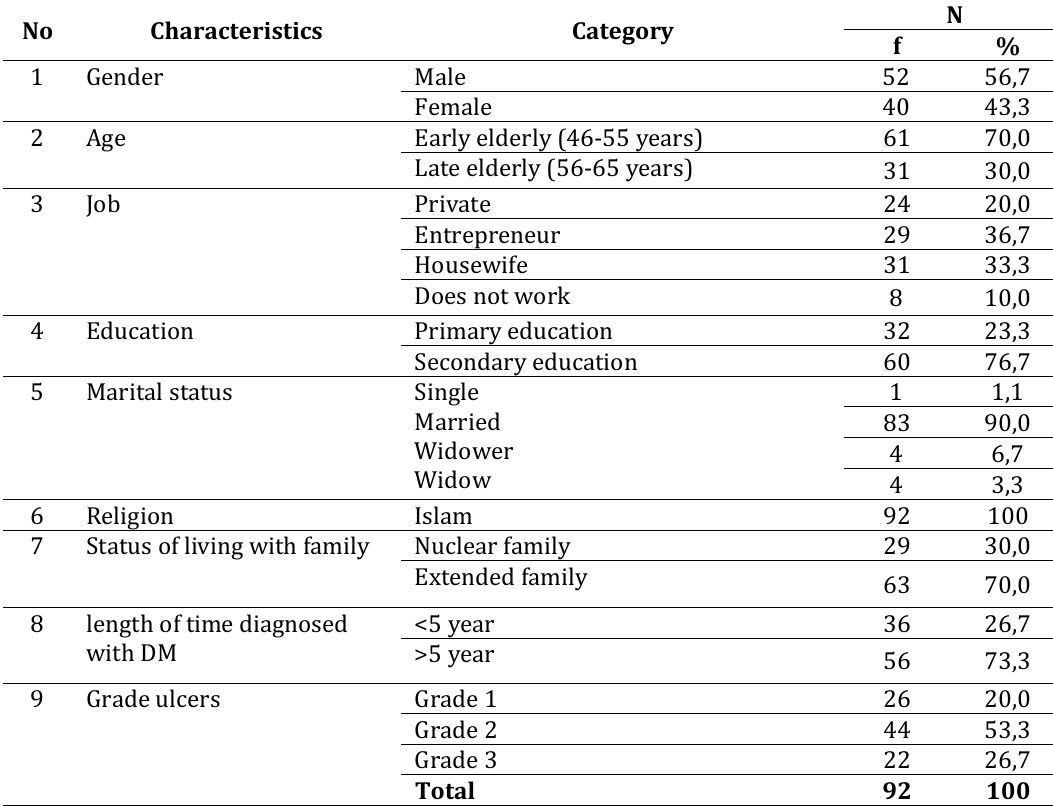
Demographic data of